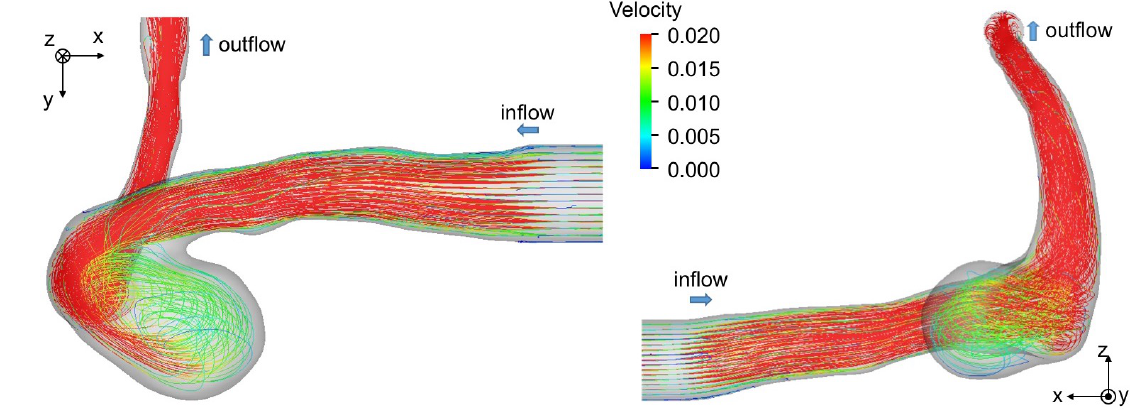
Figure 8. Flow structure in cerebral artery. The streamlines are drawn by using the result of LBB.